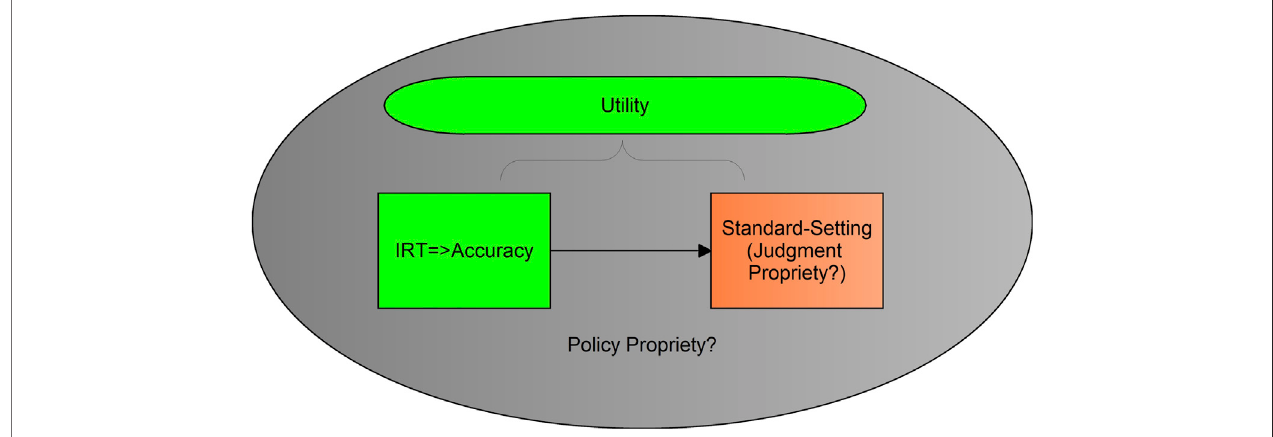
FIGURE 7 | Evaluation Overview. Note. Green indicates positive evaluation; orange indicates caution; grey indicates